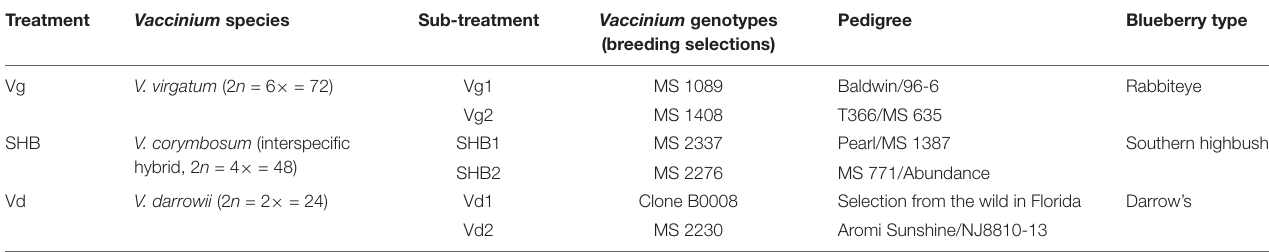
TABLE 1 | Description of species and cultivars of Vaccinium used in the